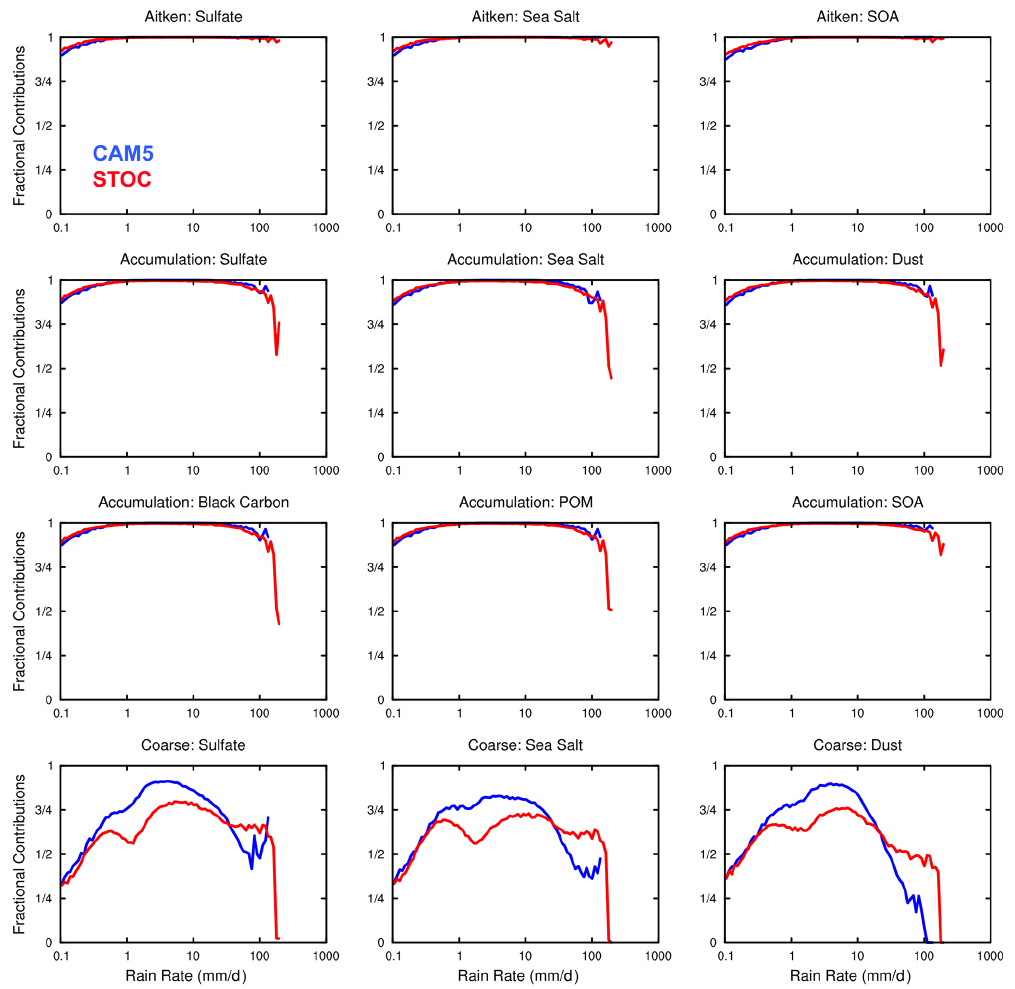
Figure 8. Fractional contributions of wet removal of aerosols from convective clouds to the total amount of aerosol wet deposition over 20 ◦ S, 20 ◦ N in CAM5 (blue) and STOC (red) runs. The distributions are scaled by (cid:49) ln (R) = (cid:49)R/R , which has units of mmd − 1 /mm d − 1 and is a unitless scaling